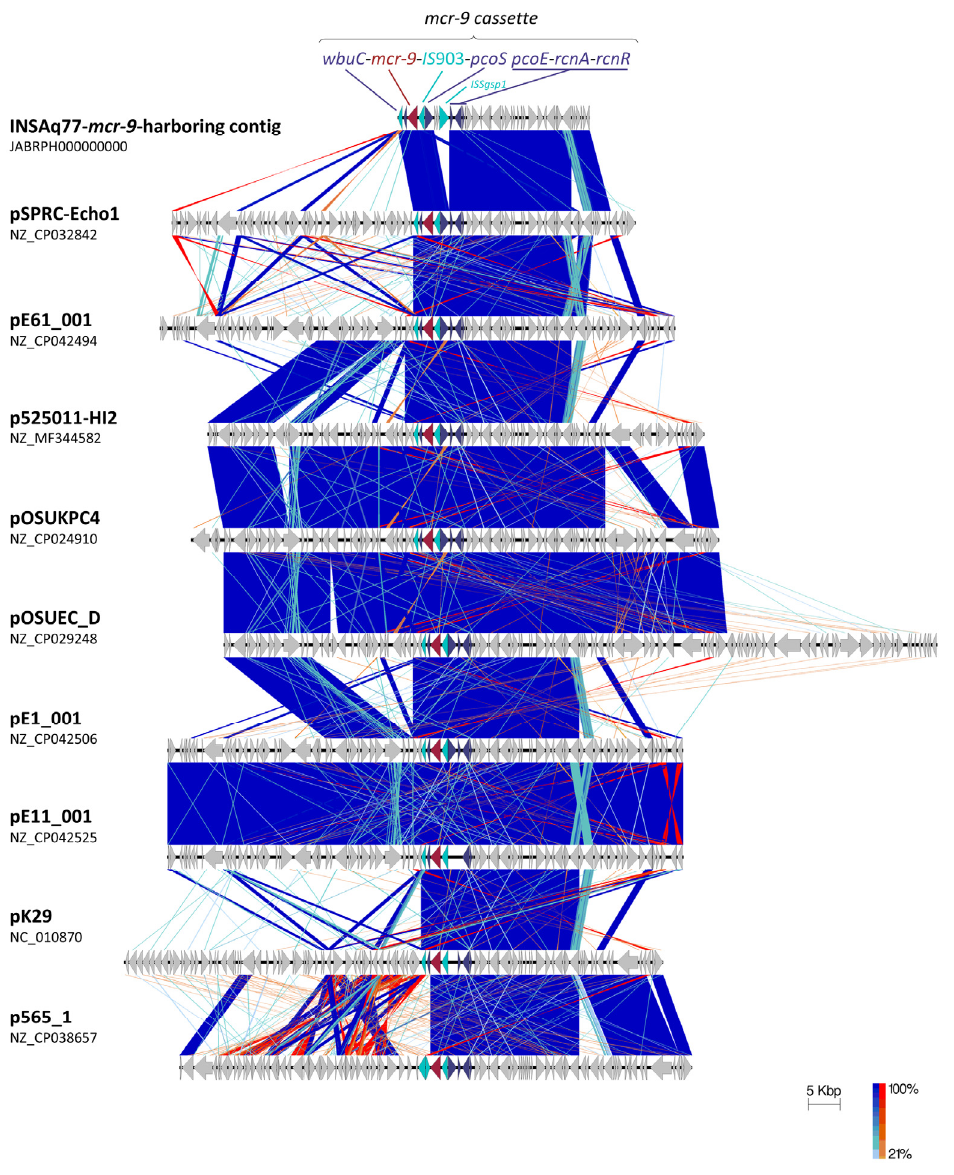
Figure 4. Schematic representation of the genetic environment of INSAq77 mcr-9.1 -containing contig with others IncHI2 mcr-9 -harboring plasmids. Boxed arrows indicate direction of transcription for all genes. Blue bars: normal tblastx matches; red: Inverted matches; depth of shading: percentage blast match. Color-coding for the genes inside mcr-9 cassette: dark red, mcr-9 gene; cyan, mobile DNA; purple, other genes; grey, other CDSs. The scale is represented in base pairs.